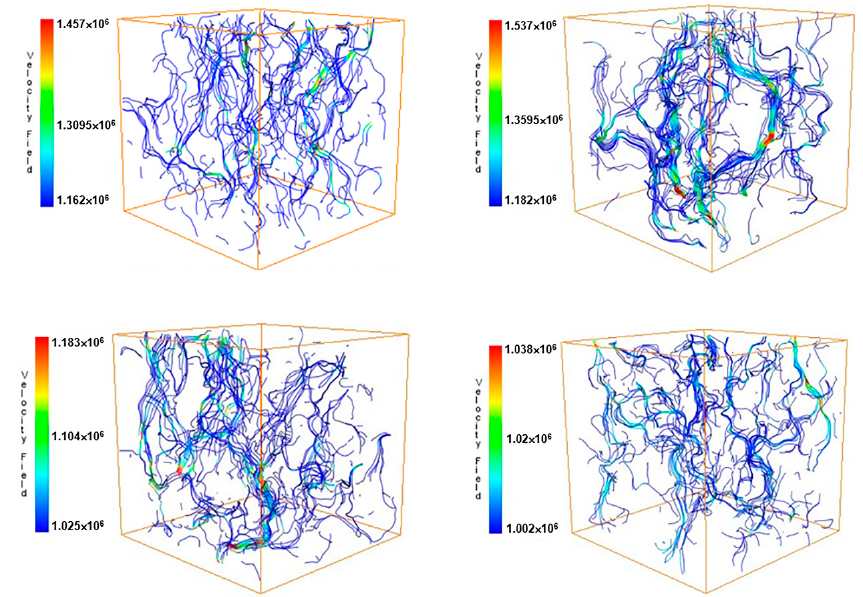
Figure 11. Flow channel distributions of the seepage simulation.